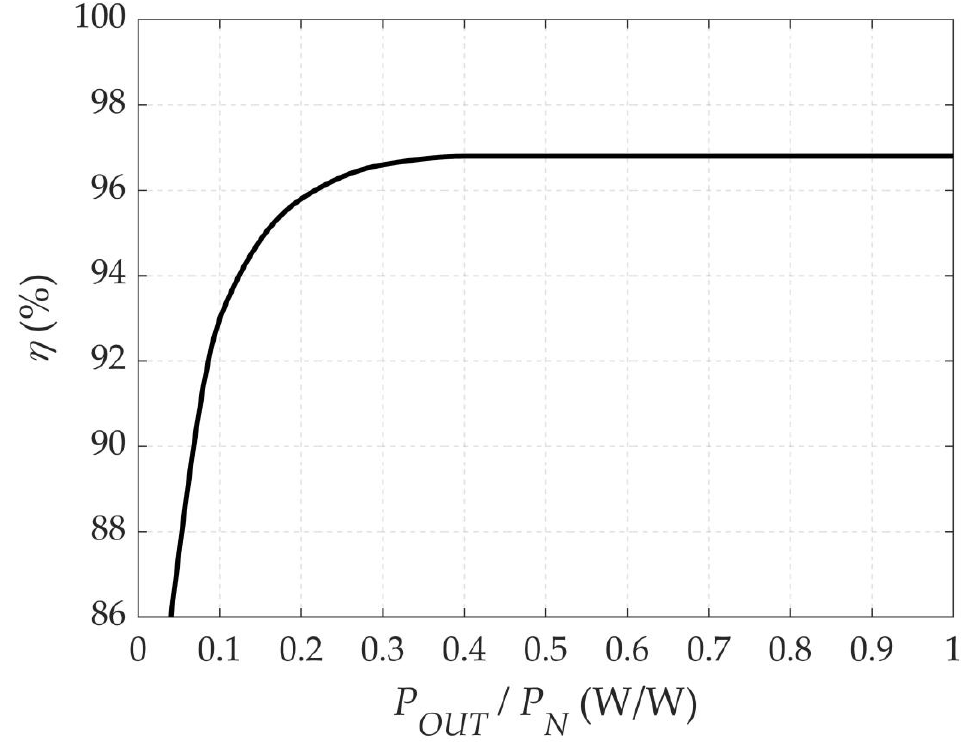
Figure 7. Typical change in the inverter capacity in the function of relative output power (averaged characteristics for the acceptable change in the inverter input voltage).